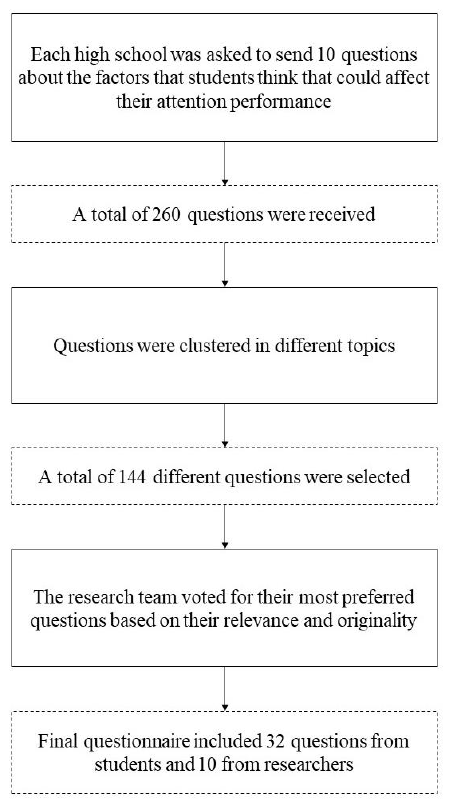
Figure 1. Co-creation process of the questionnaire.